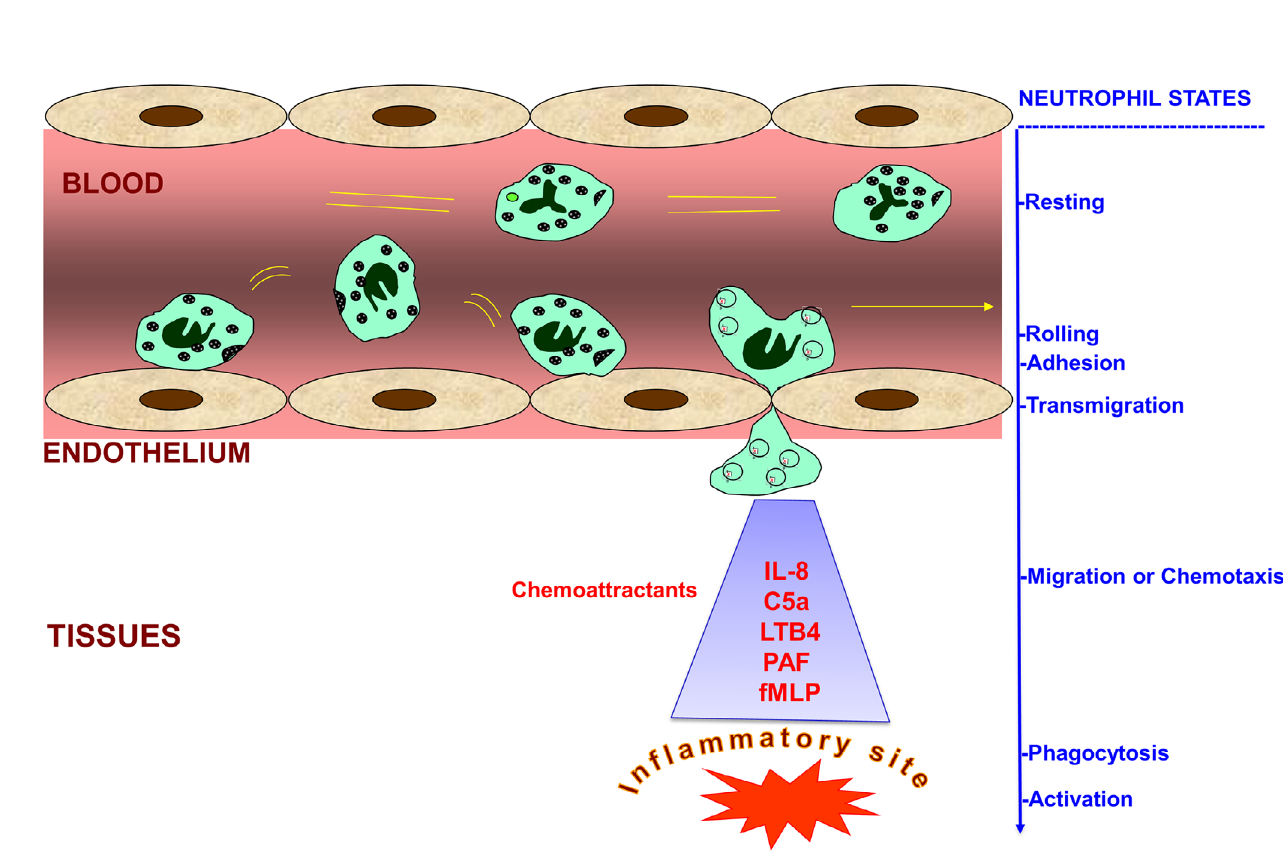
Figure 1. Migration of neutrophils from blood to the inflammatory site. Circulating neutrophils are in a resting state, also known as the dormant state. Upon inflammation, neutrophils start rolling, adhere and migrate to the inflammatory site, attracted by a multitude of chemoattractants such as IL-8, C5a, LTB4, PAF and